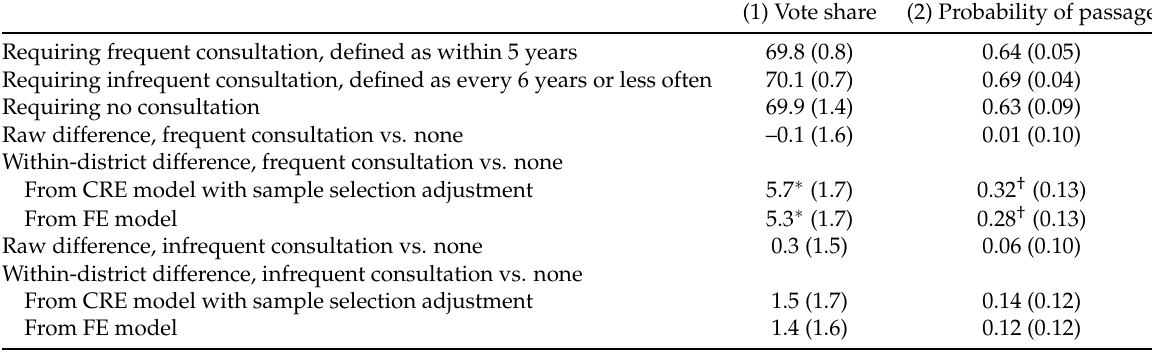
Table 2: Share of yes votes and passage as a function of direct consultation in ballot measures for California school district parcel taxes,